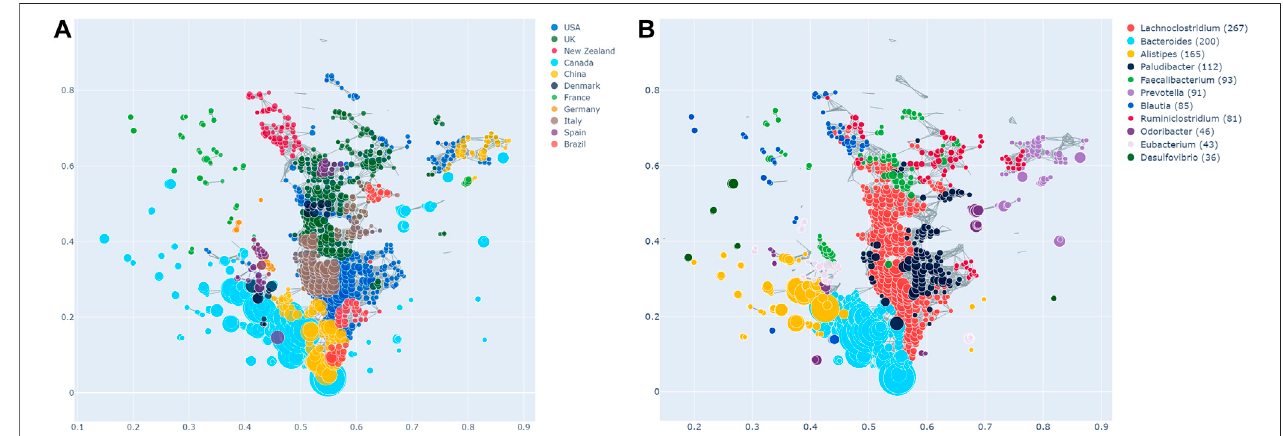
FIGURE 2 | (A) Network strati fi cation of the countries in the dataset, showing the enriched nodes. Note that Tanzania is not included here, as it did not have any signi fi cantly enriched nodes. However, this does not necessarily imply the absence of an effect. (B) Network strati fi cation of the taxa with the most enriched